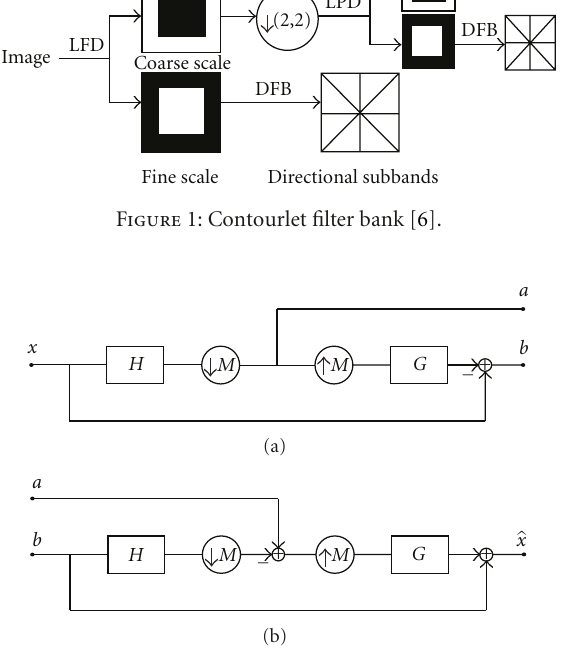
Figure 2: Laplacian pyramid scheme (a) analysis and (b) recon- struction